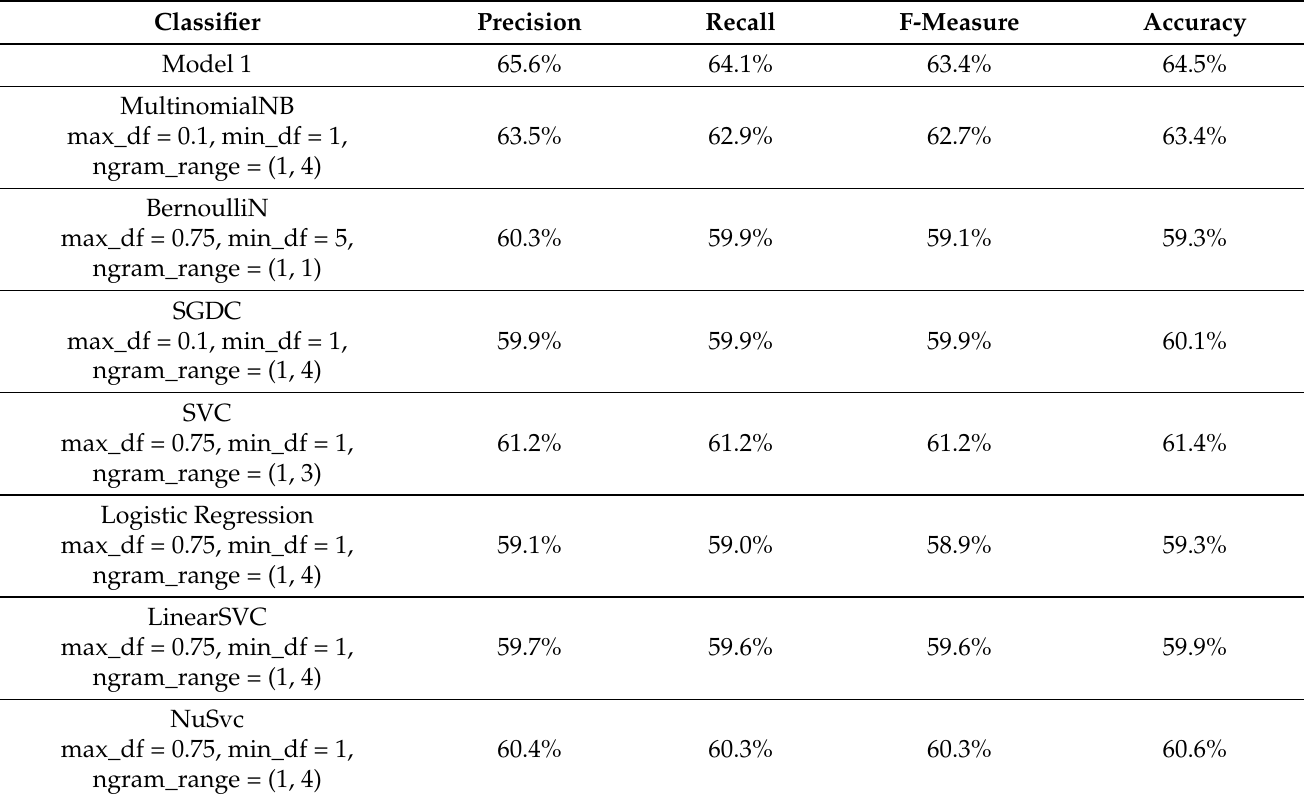
Table 6. Results of two-way ADI problem (classes 1 and